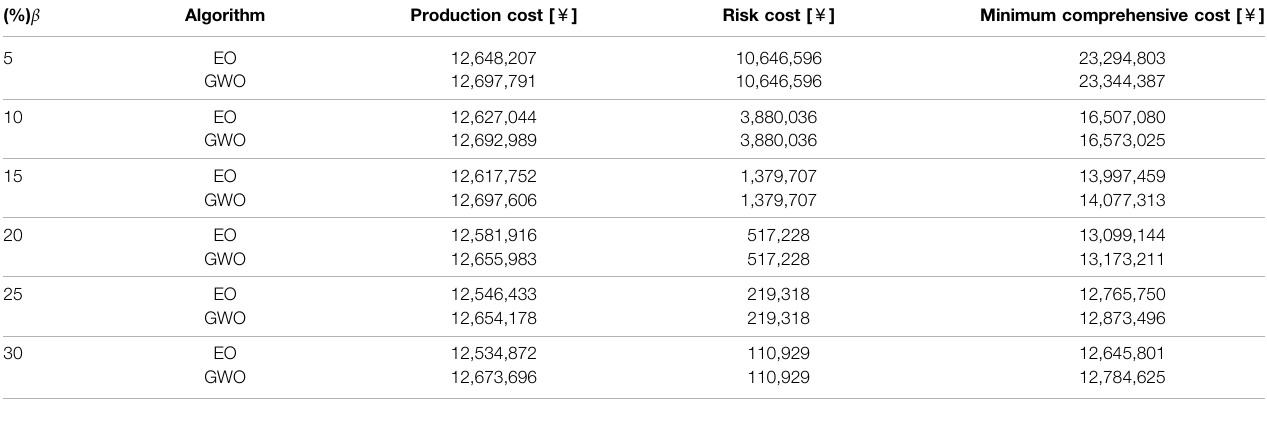
TABLE 1 | The production cost, risk cost and minimum comprehensive cost under different β values.